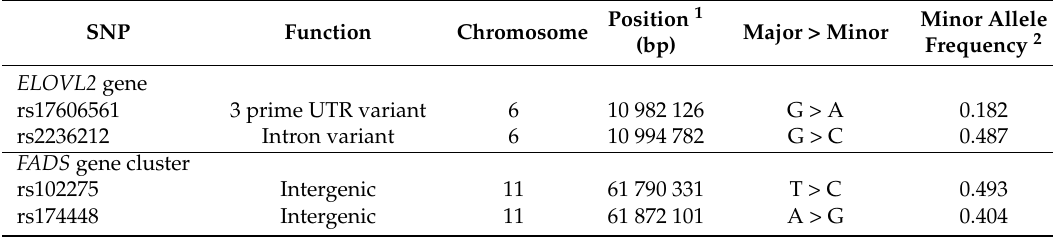
Table 2. Characteristics of single nucleotide polymorphisms in the ELOVL2 gene and the FADS gene